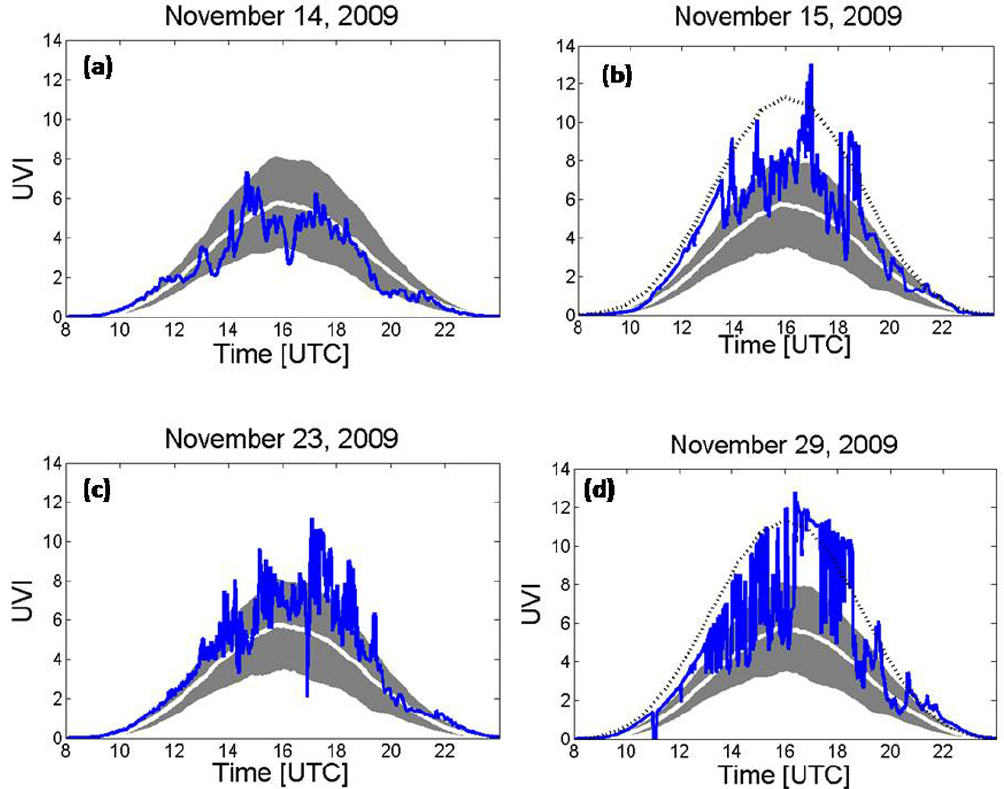
Fig. 7. Time evolution of UV index at R´ıo Gallegos. The measurements were obtained with a GUV 541 for 14 November (a) , 15 Novem- ber (b) , 23 November (c) and 29 November (d) and are plotted as blue lines. November monthly mean of UVI is shown as a white line and the shadow grey area corresponds to ± 1SD. Modeled UVI for 15 and 29 November are shown as dotted black